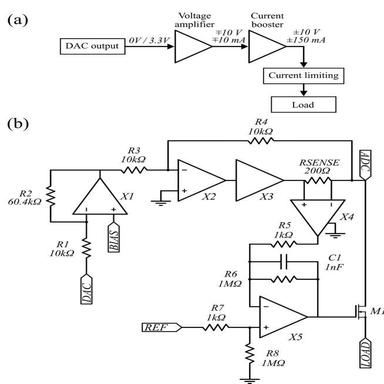
Block diagram (a) and simplified schematic (b) of the realised voltage generator and current limiting circuit.